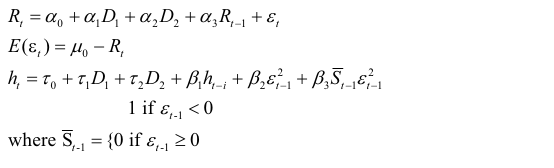
Table 7. Empirical results for the AR (1)-GJR GARCH (1,1) model